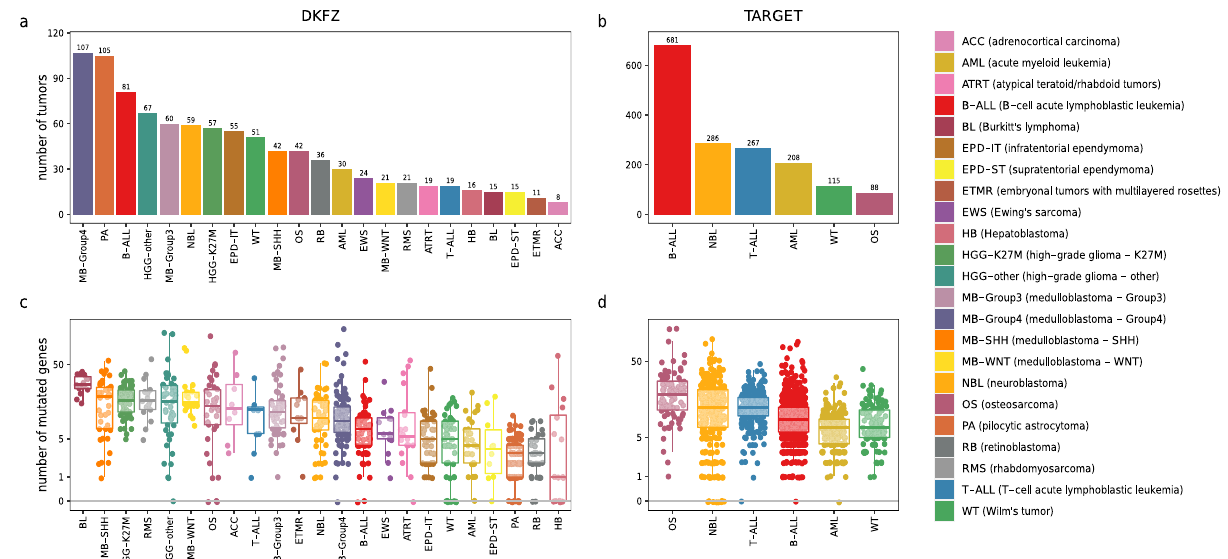
Fig. 1 Number of samples and mutated genes per cancer type. a , b The number of samples per cancer type in the DKFZ ( a ) and TARGET ( b ) data sets used in this study before sample fi ltering (e.g., removal of hypermutators and relapse tumors). c , d Number of mutated genes identi fi ed in each individual tumor per cancer type for the DKFZ ( c ) and TARGET ( d ) data sets after sample fi ltering. Box-plots ’ center line: median; box limits: upper and lower quartiles; lower (higher) whisker: smallest (largests) observation greater (less) than or equal to lower (higher) box limit — ( + ) 1.5× interquartile range. Points on the horizontal axis represent tumor samples without any mutated genes. Mutated genes are de fi ned as genes that harbor at least one exonic mutation with a likely functional consequence. Only SNVs and small indels were considered. Source data underlying Fig. 1 can be found in Supplementary Data 2.